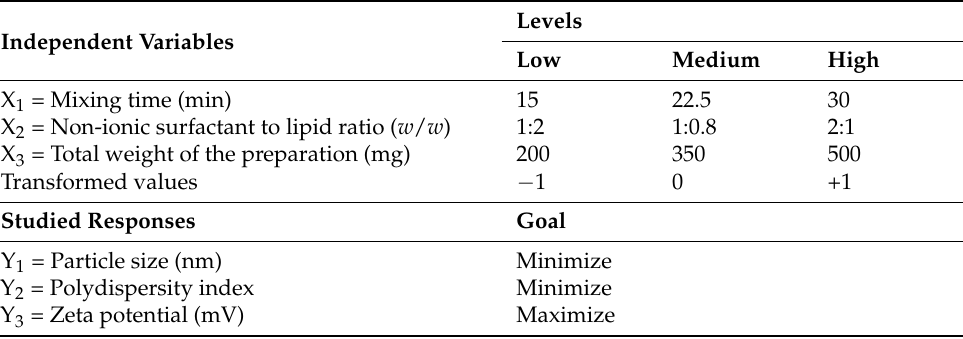
Table 1. Independent and dependent variables in Box–Behnken design for the optimization of Tadalafil-loaded